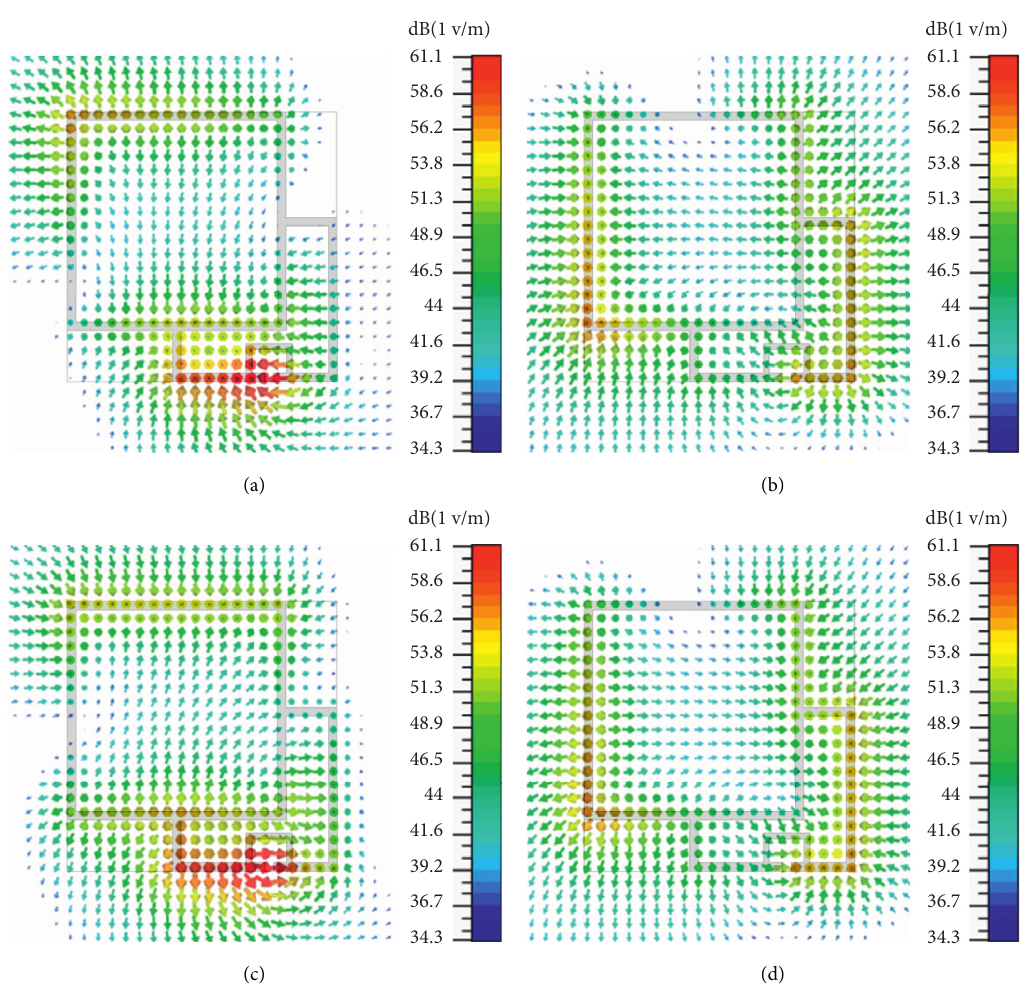
Figure 11: The simulated electric field under variable time periods ( T ): (a) t � 0, (b) t � T /4, (c) t � T /2, and (d) t � 3 T